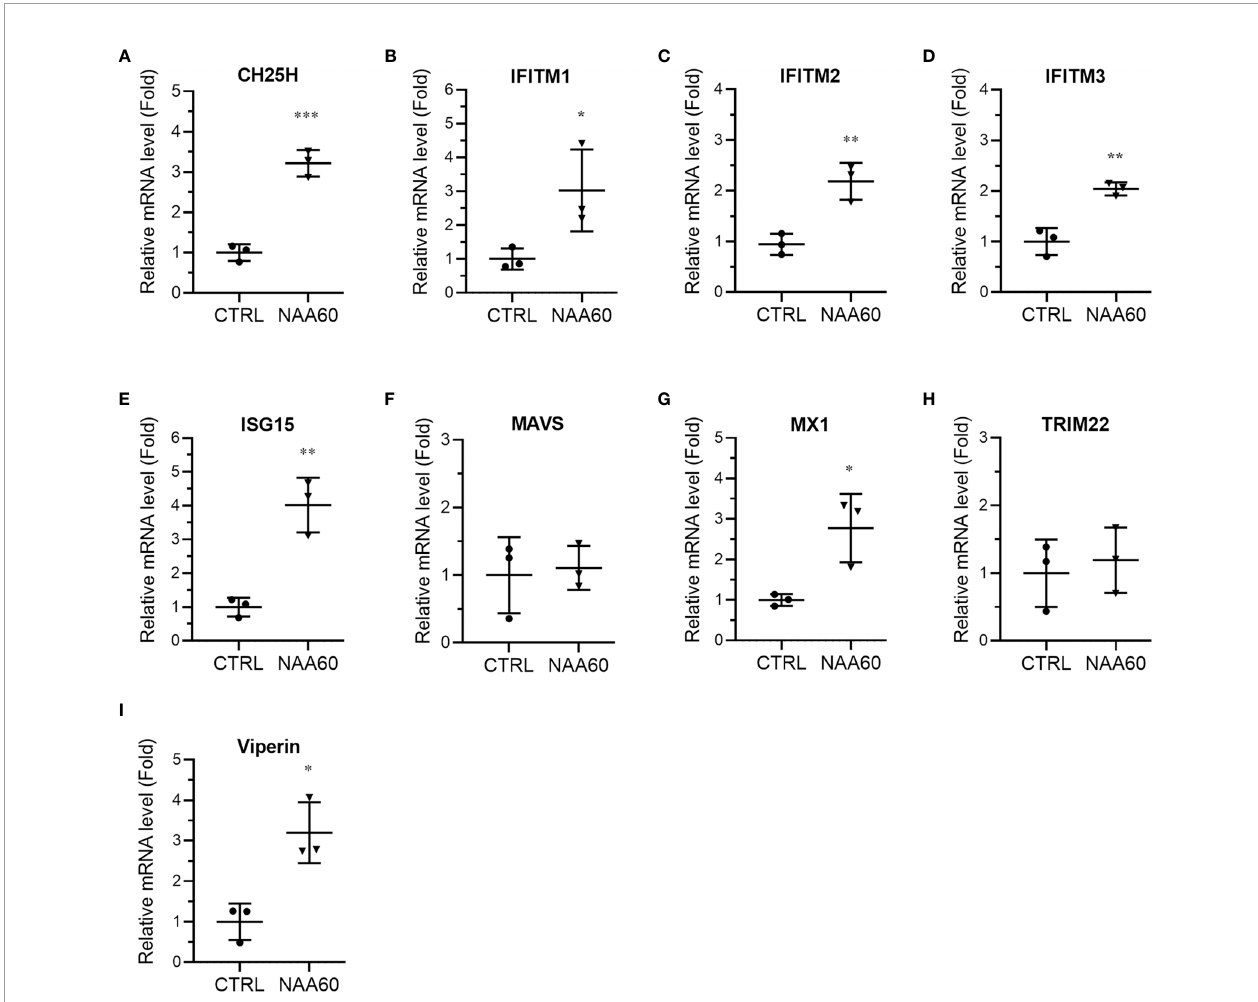
FIGURE 5 | The depletion of NAA60 increases IAV-induced expression of various ISGs. A549 cells were transfected with 10 nM of CTRL or NAA60 siRNA for 72 h. One set of the cells was processed to con fi rm the depletion of NAA60 by RT-qPCR as in Figure 1A (not shown). The other set of the cells was infected with PR8 at an MOI of 1.0 for 3 h, and the cells were processed to detect and calculate the mRNA levels of CH25H (A) , IFITM1 (B) , IFITM2 (C) , IFITM3 (D) , ISG15 (E) , MAVS (F) , MX1 (G) , TRIM22 (H) , and viperin (I) by RT-qPCR as in Figure 1A . Error bars represent means ± standard deviation of at least three biological replicates; ***P ≤ 0.001, **P ≤ 0.01, *P ≤